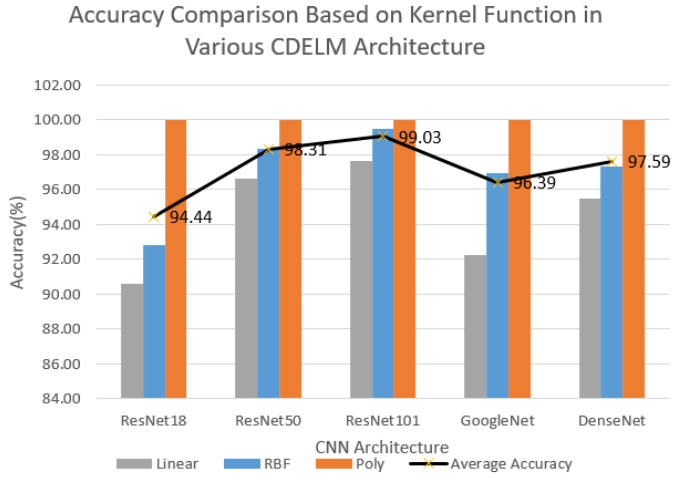
Figure 11. Results of Experiment on 2 class MESSIDOR Dataset.